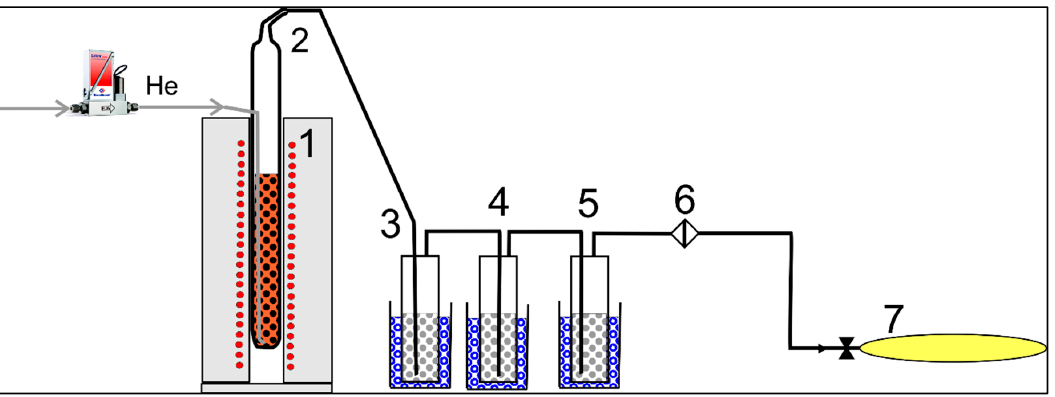
Figure 1. Scheme of the pyrolysis apparatus: 1—oven, 2—quartz reactor, 3—5 ice-water-cooled impingers, 6—porous filter, 7—Tedlar bag.